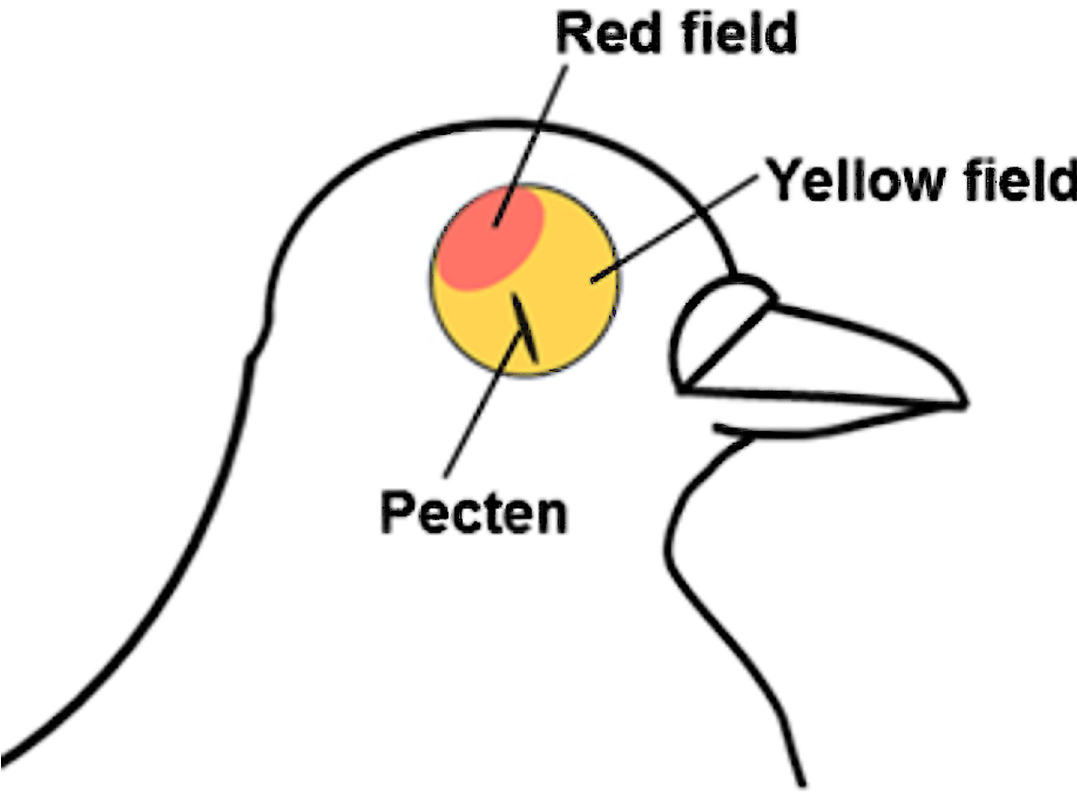
Fig 1. Scheme of fundus of the pigeon eye according to [16]. Positions of the red and yellow fields are shown.